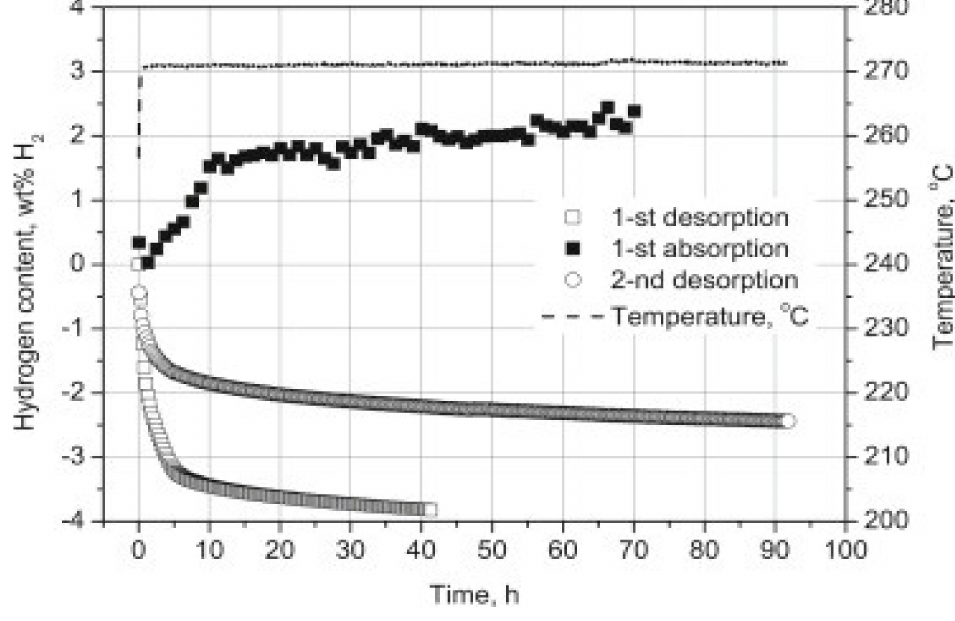
Figure 6. Cycling properties of hydrogen sorption of γ -Mg(BH 4 ) 2 + 2 mol % TiO 2